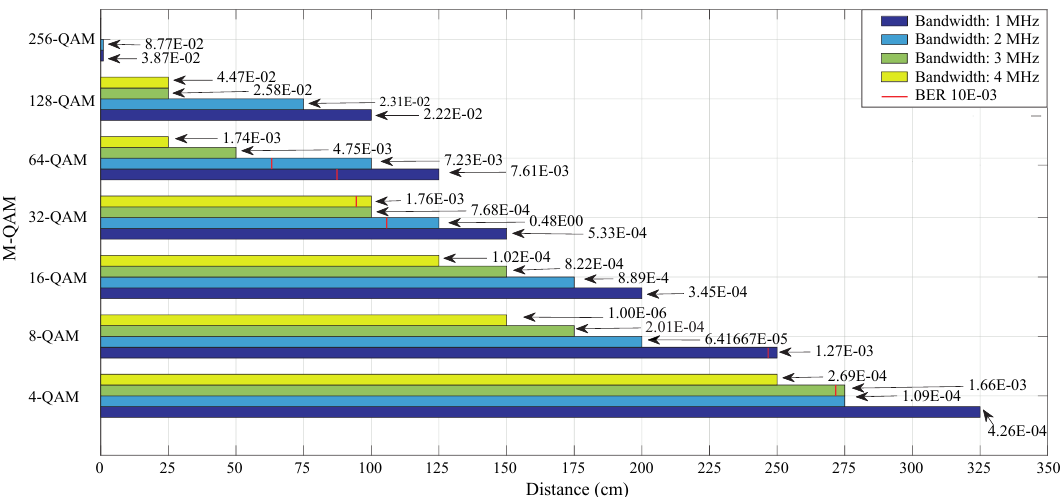
Figure 9. BER/distance from center relationship for ceiling light with different M-QAM and